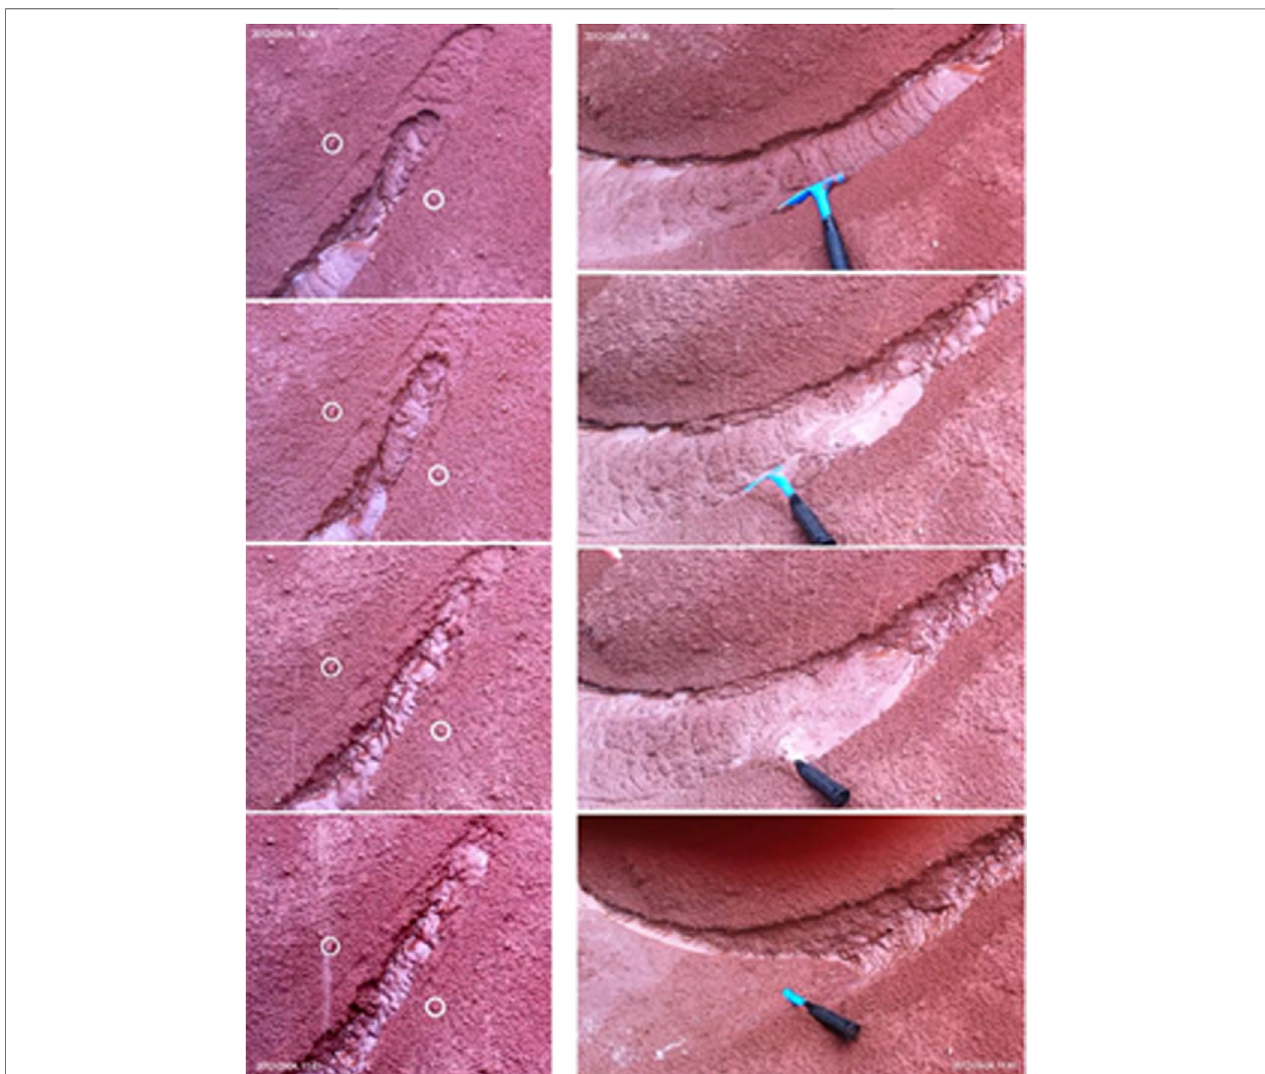
FIGURE 6 | Creep or mud fl ow occurs during continuous rain was observed during the monitoring period.